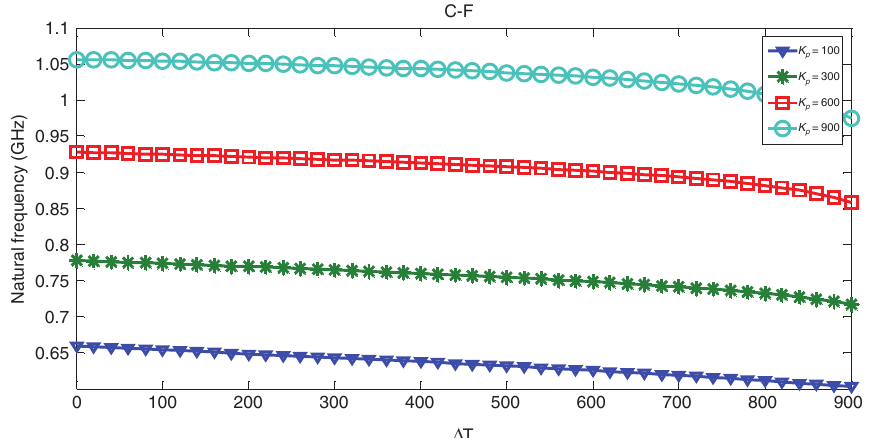
Figure 12: The effect of Pasternak stiffness on the natural frequency with clamped-free boundary condition.